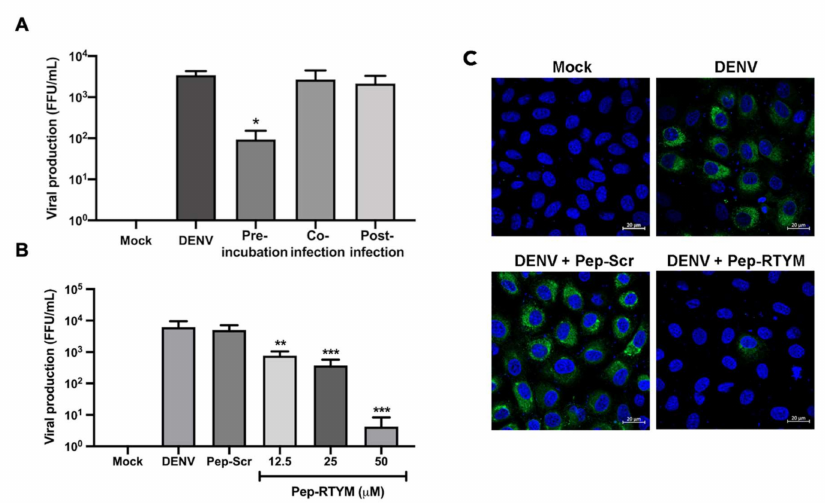
Figure 3. Inhibitory e ff ect of Pep-RTYM peptide inhibitor on DENV infection in Vero cells. DENV2 was treated with 25 µ M of Pep-RTYM prior to virus infection (pre-incubation), during virus infection (co-infection), or upon virus infection (post-infection) to investigate the e ff ect of this peptide on virus replication ( A ). The inhibitory e ff ect of Pep-RTYM was shown to lower virus production ( B ) and the number of infected cells ( C ) compared to the irrelevant negative peptide (Pep-Scr) using virus titration and immunofluorescence assay, respectively. Asterisks were used to indicate di ff erent levels of statistical significance, as follows: * p < 0.05; ** p < 0.01, and *** p <